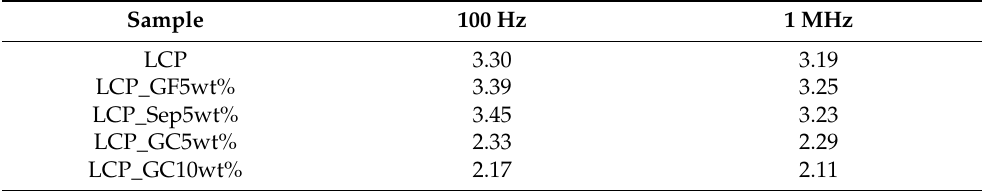
Table 2. Dielectric constants of the LCP composites at two different frequencies (100 Hz and 1 MHz).